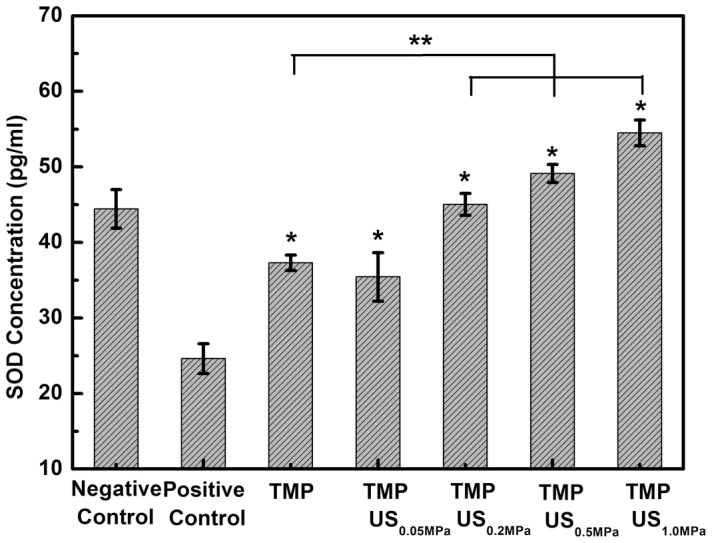
Effect of TMP combined with US exposure on glutamate-induced release of SOD in PC12 cells.Each bar represents the mean plus or minus the standard deviation (n = 5, *p<0.01 compared with the positive control group; **p<0.01 compared with the TMP group).